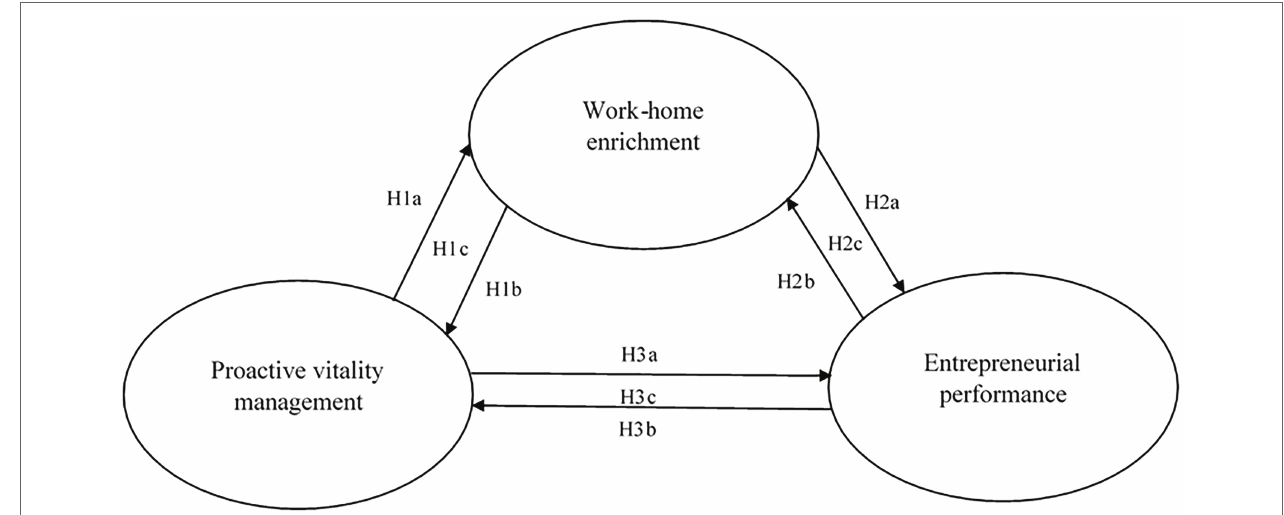
FIGURE 1 | The hypothesized mediation